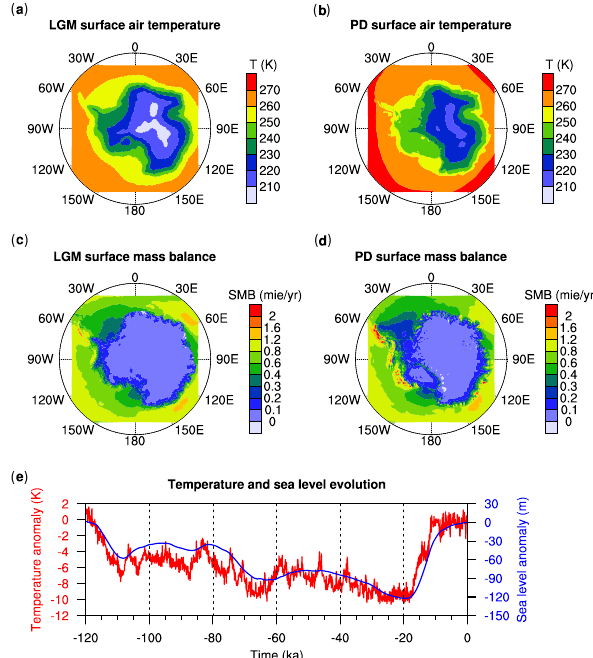
Figure 2. RACMO2 output fields of (a) the LGM temperature, (b) the PD temperature, (c) the LGM surface mass balance in metres ice equivalent per year and (d) the PD surface mass balance. Panel (e) – the temperature evolution according to the EPICA Dome C ice core (Jouzel et al., 2007) is shown in red and the sea level evolution according to Bintanja and van de Wal (2008) in